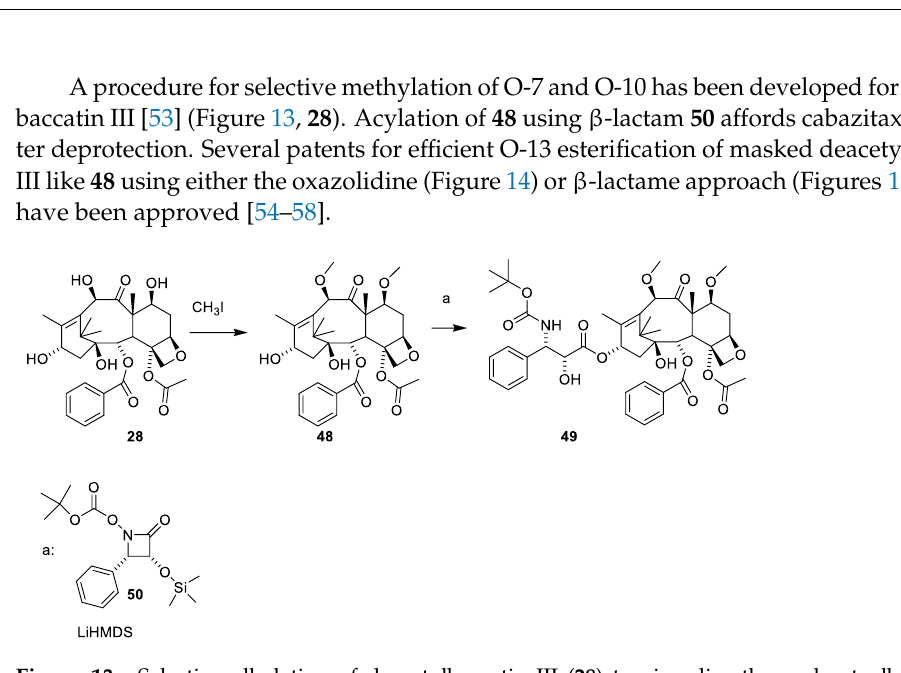
Figure 13. Selective alkylation of deacetylbaccatin III ( 28 ) to give dimethoxy deacteylbaccatin III ( 48 ) [53,58]. Reaction of 48 with the β -lactam 50 affords cabazitaxel ( 49 ). LiHMDS: lithium hexamethyldisilazide.